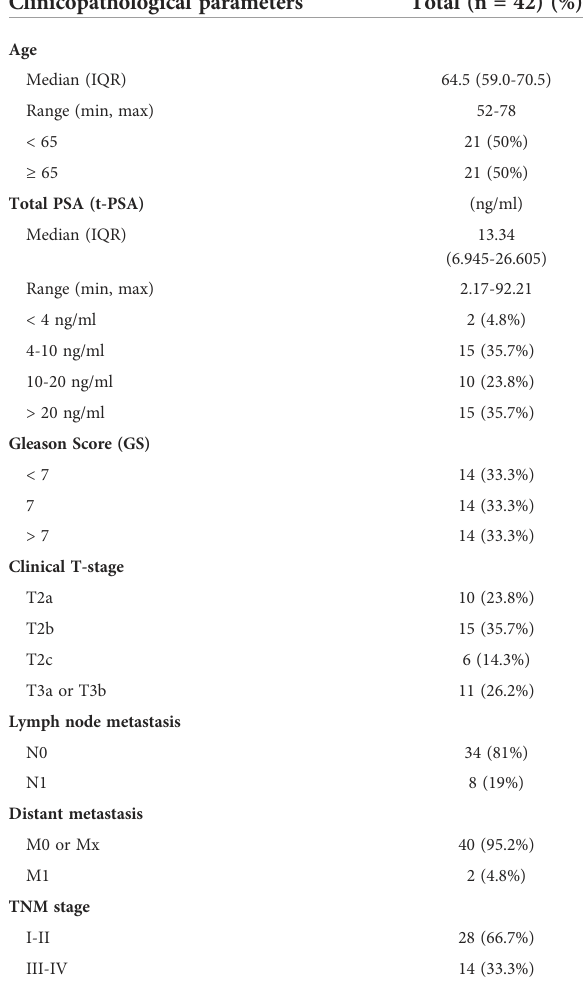
TABLE 1 Clinicopathological characteristics of clinical PCa patients. Clinicopathological